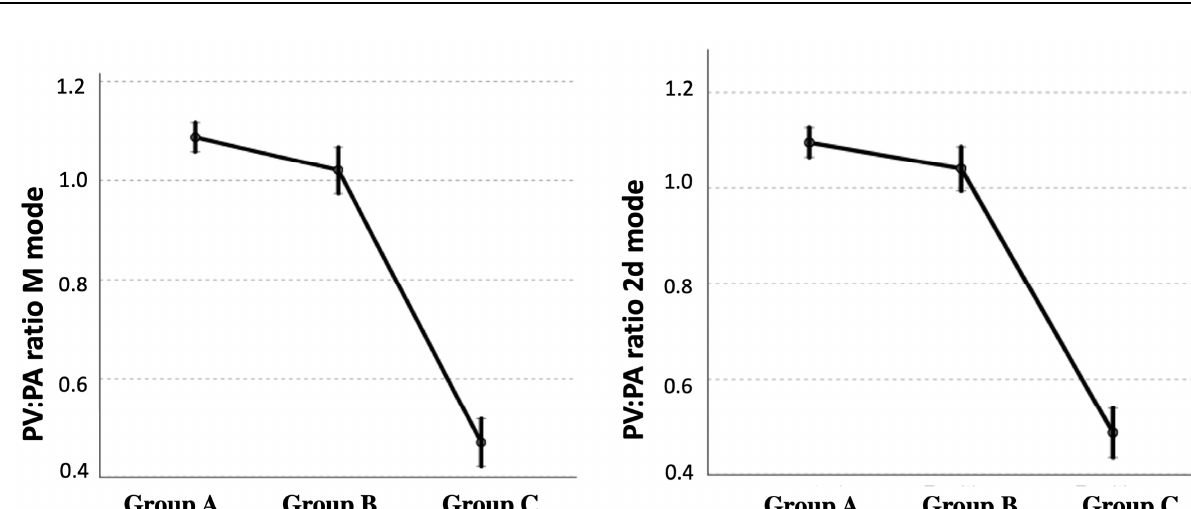
Table 1. Clinical, epidemiological, and echocardiographic parameters of the studied dogs (group A: healthy dogs, group B: heartworm-infected dogs and absence of PH, group C: heart- worm-infected dogs with PH). Data represent median and standard deviation (min–max) unless otherwise stated: RPAD index, right pulmonary artery distensibility index; TRPG, peak tricuspid regurgitation systolic pressure gradient; PT, pulmonary trunk; Ao, aorta; PV:PA pulmonary vein to pulmonary artery ratio; M mode, time–motion mode; 2D mode, two-dimensional mode; AT:ET, right acceleration time to ejection time ratio. Results for female, respiratory symptoms, and right-sided CHF are expressed as n (%). Results for parasite burden are expressed as median (range). Significant differences were found when p -value < 0.01. (*): significant differences observed between groups C and B; ( ⱡ ): signi fi cant di ff erences observed between groups C and A; ( ● ): signif- icant differences observed between groups B and A.